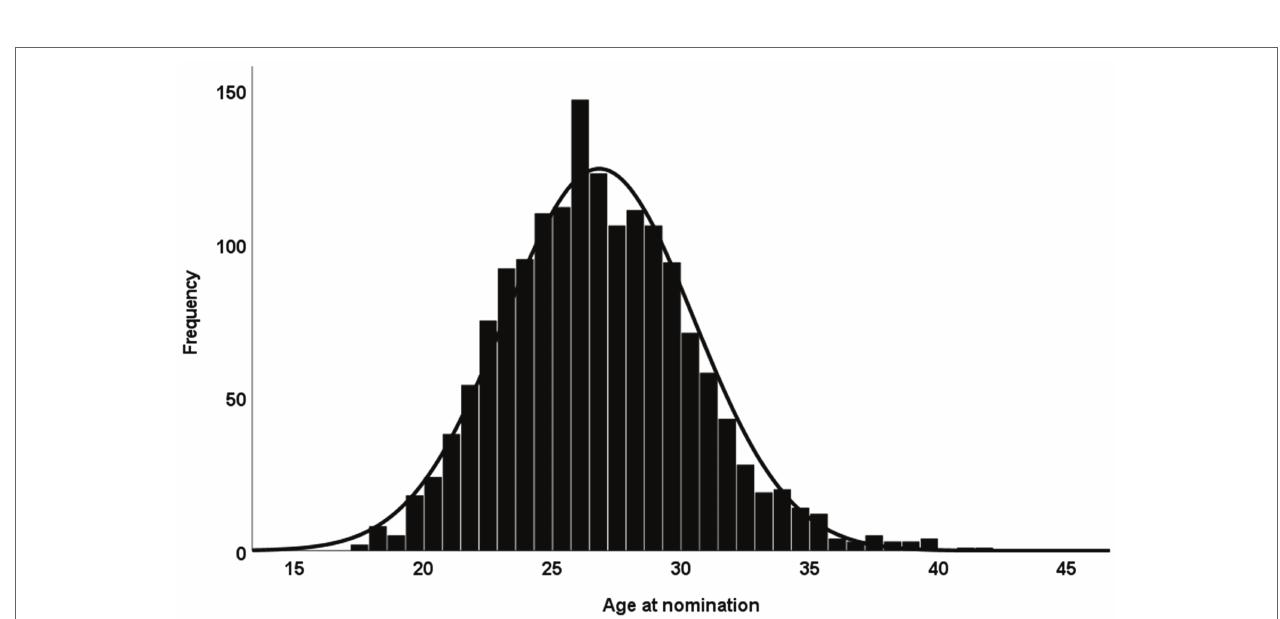
FIGURE 2 | Development of mean age at nomination from 1956 to 2019. Black dotted line indicates trendline for the entire period; red dotted line indicates development in the past two decades (1999–2019).